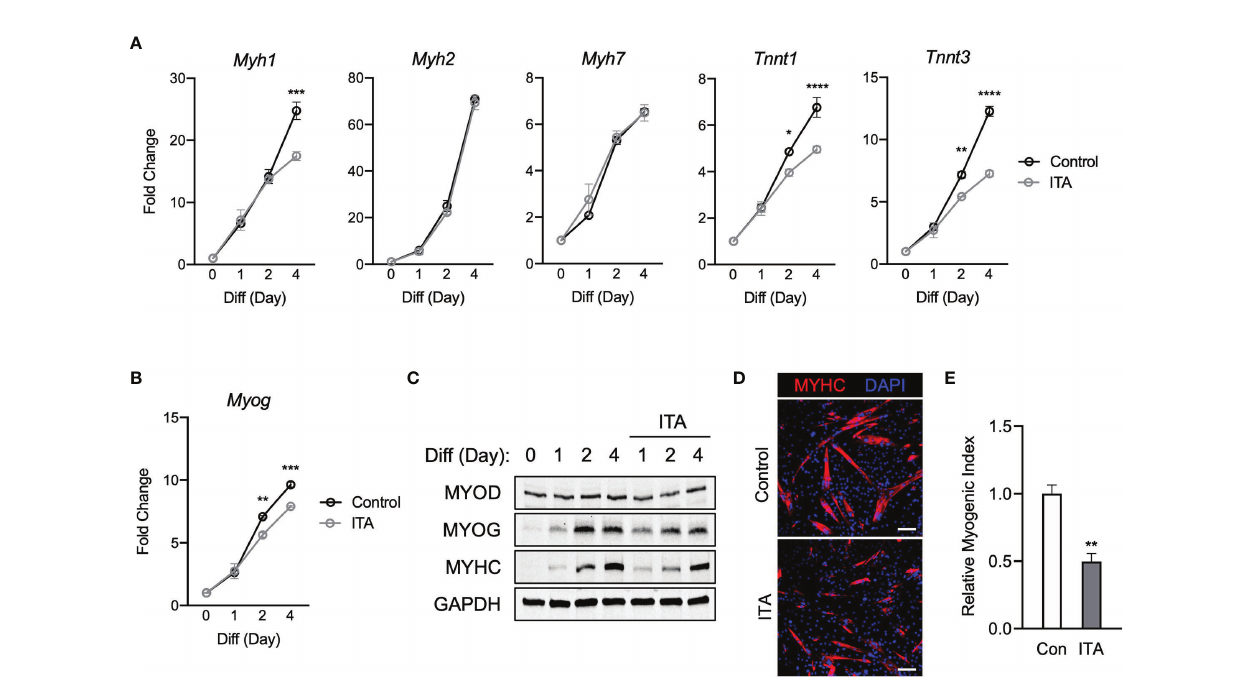
FIGURE 2 | Itaconate represses C2C12 myogenesis by modulating myogenic transcription mechanisms. (A) 4-day time course showcasing fold change differences of myogenic gene transcription levels detected via RT-qPCR when exposed to differential media with or without itaconate (7.5 mM) relative to the untreated group (n = 3). (B) Fold change of Myog mRNA expression at various time points comparing DM control groups to DM and itaconate groups relative to expression without either treatment (n = 3). (C) Western blotting data showing differences in myogenic transcription factor expression between DM treated groups and groups treated with both DM and itaconate over a 4 day time course as well as groups which were not exposed to either treatment for any period. (D) MYHC staining at day 4 of differentiation. Bar: 100 m m. (E) Relative myogenic index (percentage of total nuclei associated with myotubes). * denotes p< 0.05, ** p <0.01, *** p <0.001, **** p <0.0001 compared to control based on